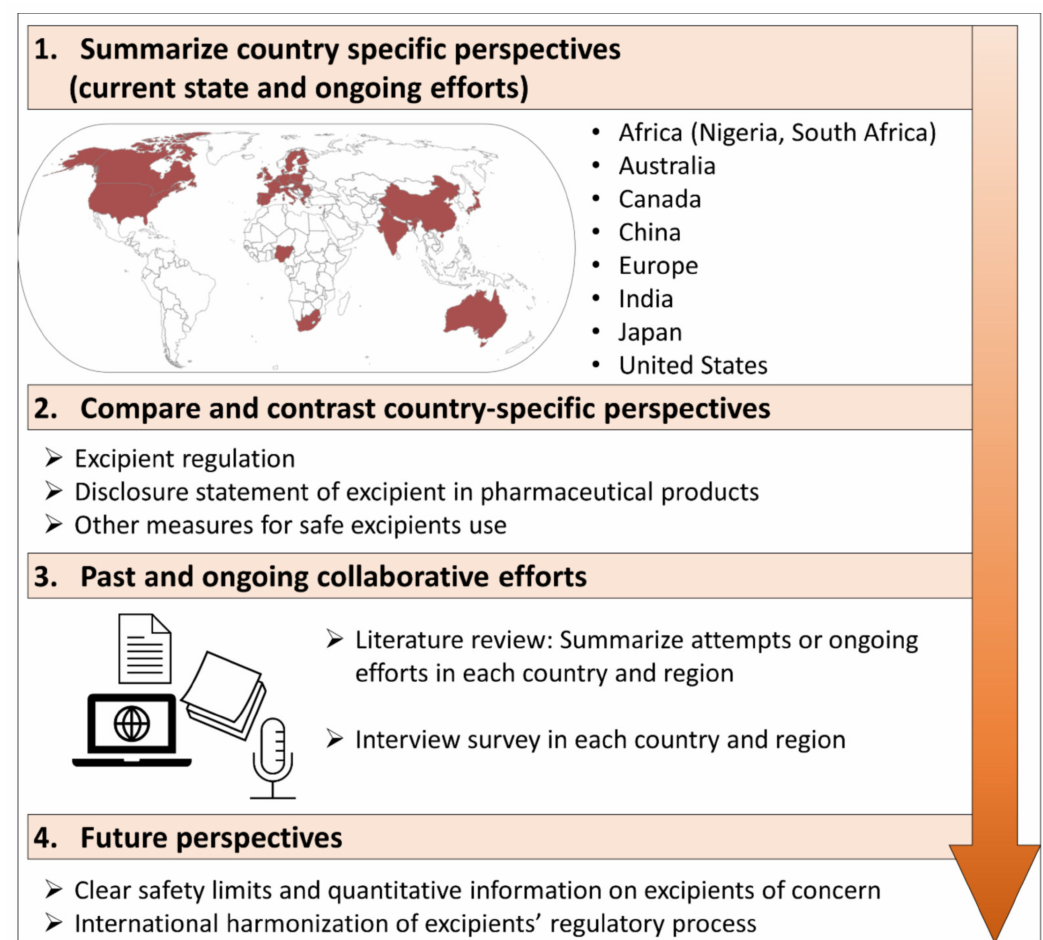
Figure 1. Concept and summary of this